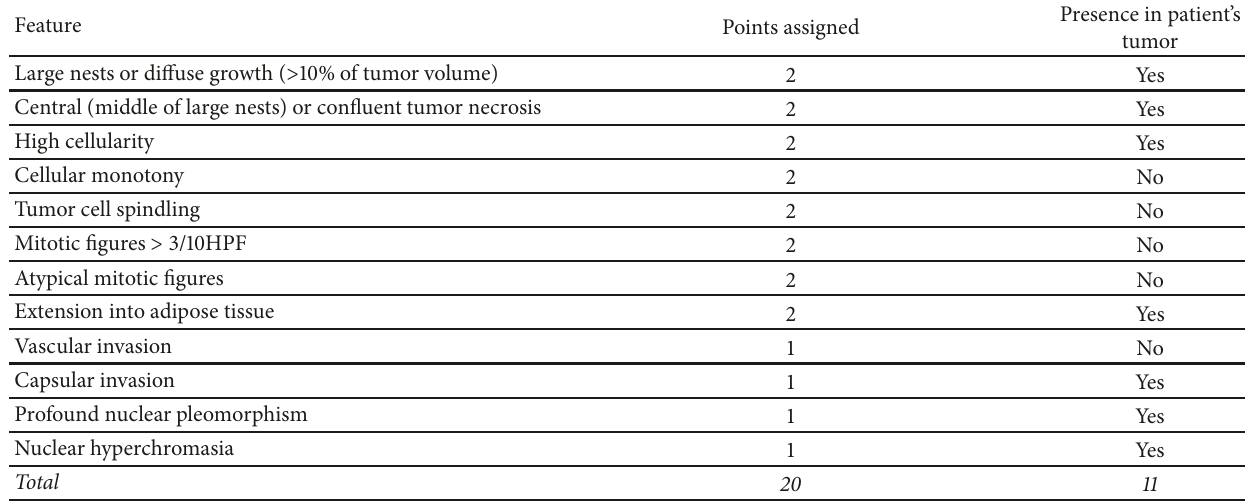
Table 2: Pheochromocytoma of the Adrenal Gland Scaled Score by